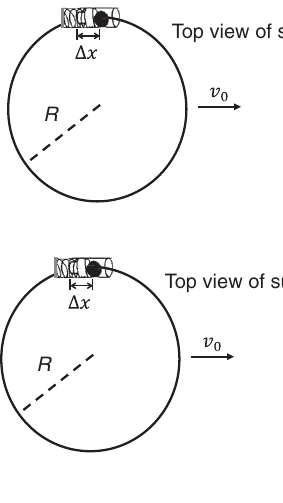
FIG. 5. The three essential equations for solving the simultaneous synthesis problems.